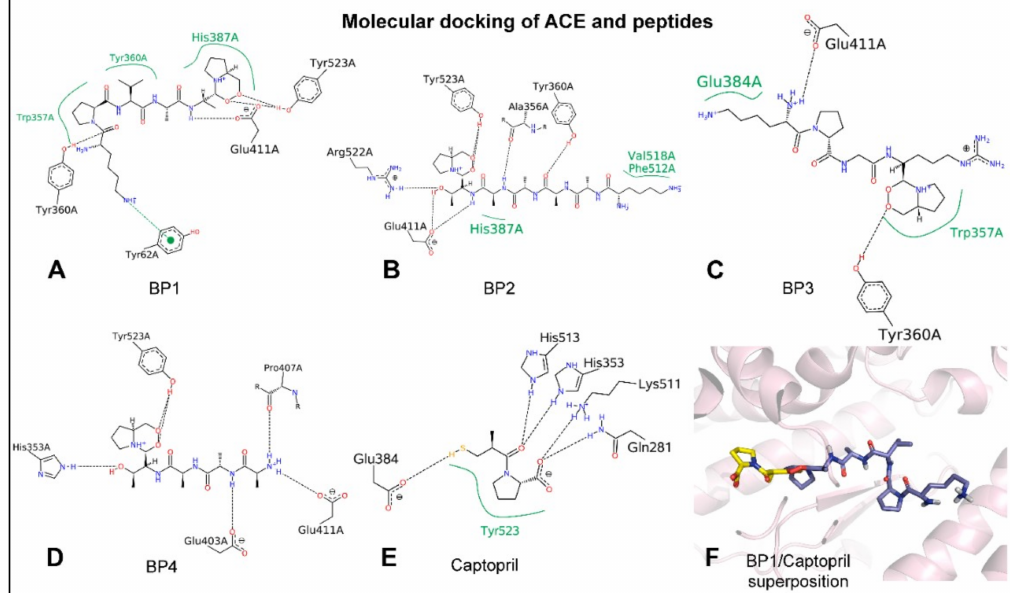
Figure 1. Depiction (in 2D) of the molecular docking between catalytic residues from the active site of ACE (PDB: 4APJ) and the bioactive peptides. ( A ) Peptide 1 (BP1) KPVAAP, ( B ) Peptide 2 (BP2) KAAAATP, ( C ) Peptide 3 (BP3) KPGRP, and ( D ) Peptide 4 (BP4) AAATP. ( E ) Captopril. ( F ) The superposition (in 3D) of BP1 (in purple) and captopril (in yellow) in stick representation. Continuous green lines represent hydrophobic interactions, while black dashed lines show hydrogen bonds. The absence of hydrophobic stabilization in the case of BP4 ( D ) might explain its high IC 50 value. Moreover, BP2 ( B ) showed small hydrophobic interaction areas compared with BP1 ( A ) and BP3 ( C ), which contained voluminous hydrophobic